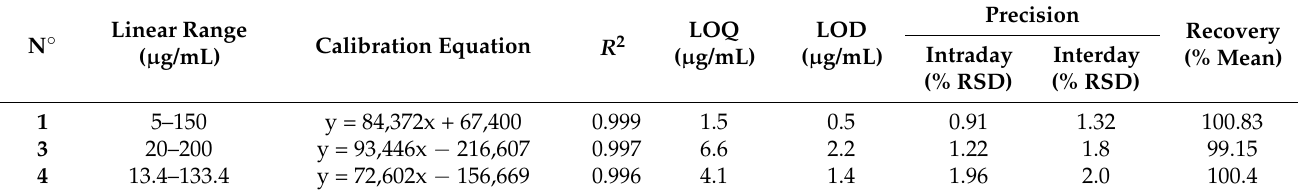
Table 3. Contents (mg/g) compounds in four batches of the B. heterophylla ( n = 3).